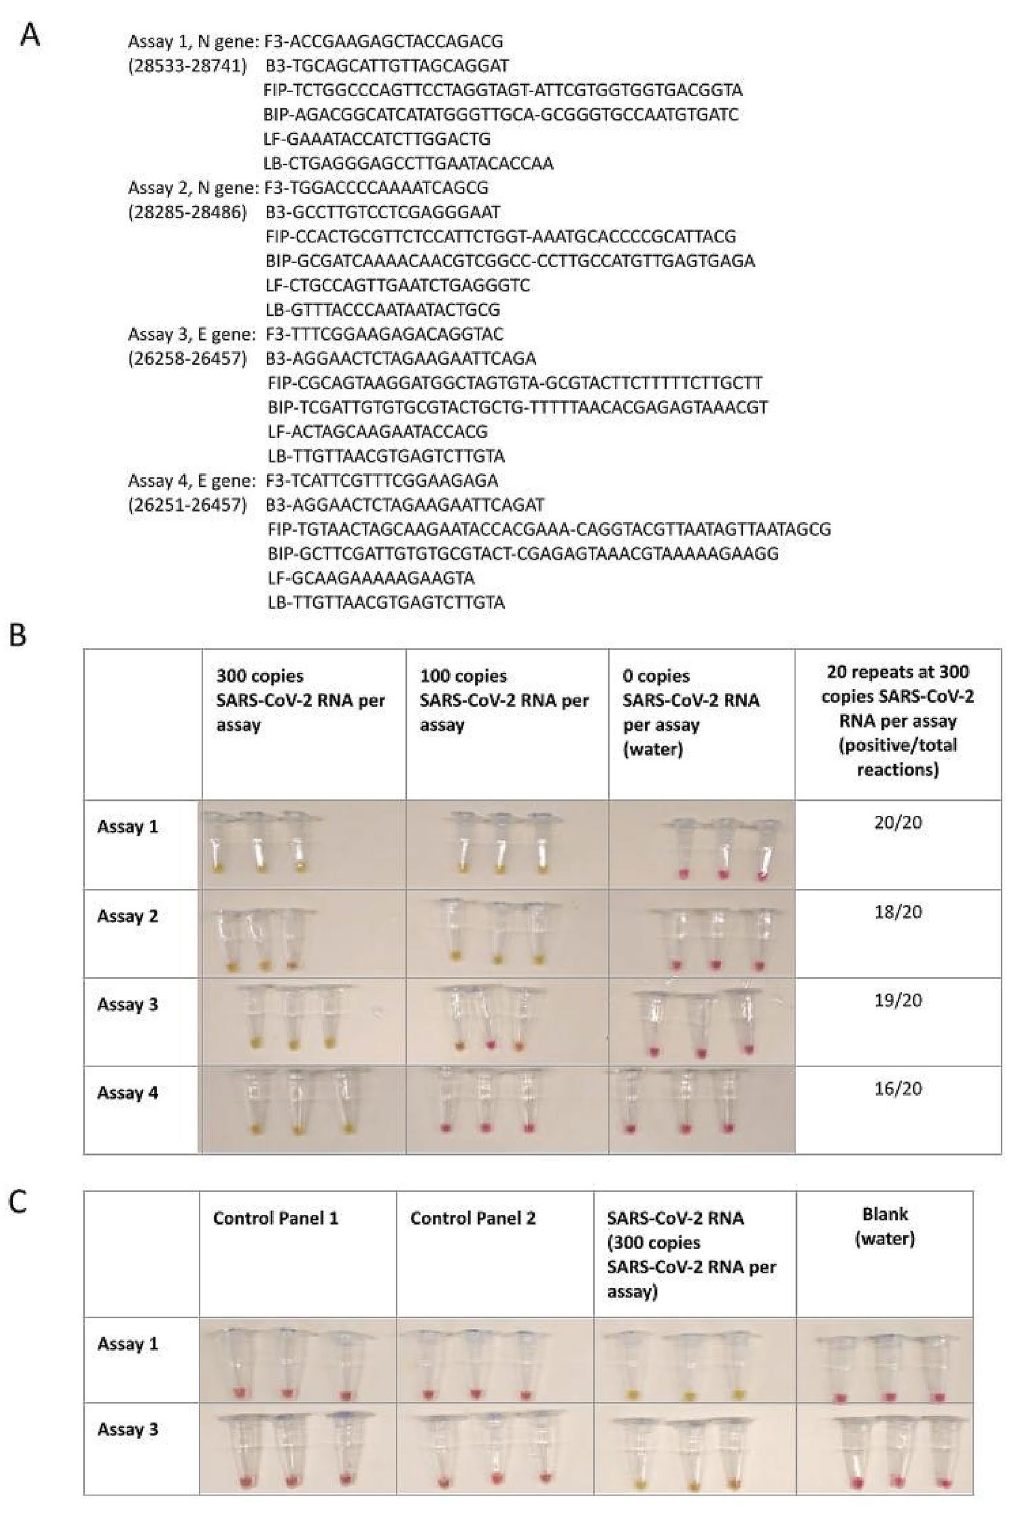
Figure 2. LAMP assays design and validation. ( A ) Primer sequences of LAMP assays. ( B ) Limit of detection of the assays. ( C ) Cross-reactivity validation using NATtrolTM Respiratory Panel 2 (RP2) Controls. Pink color reaction indicates negative and yellow color indicates positive result. Nuclease free water was used in blank